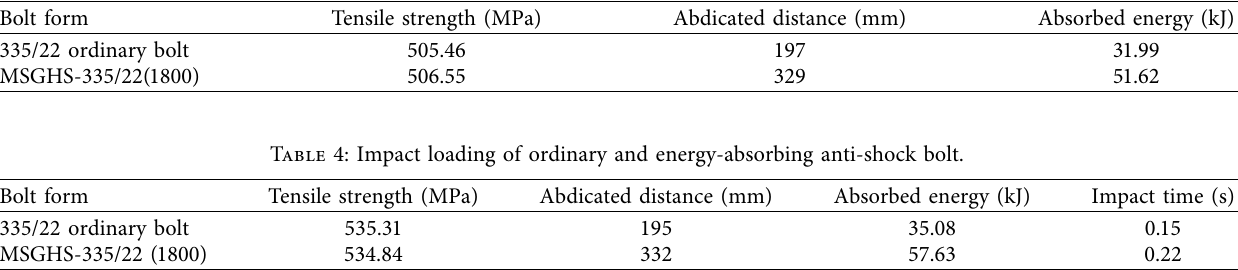
Table 3: Static loading of ordinary and energy-absorbing anti-shock bolt.